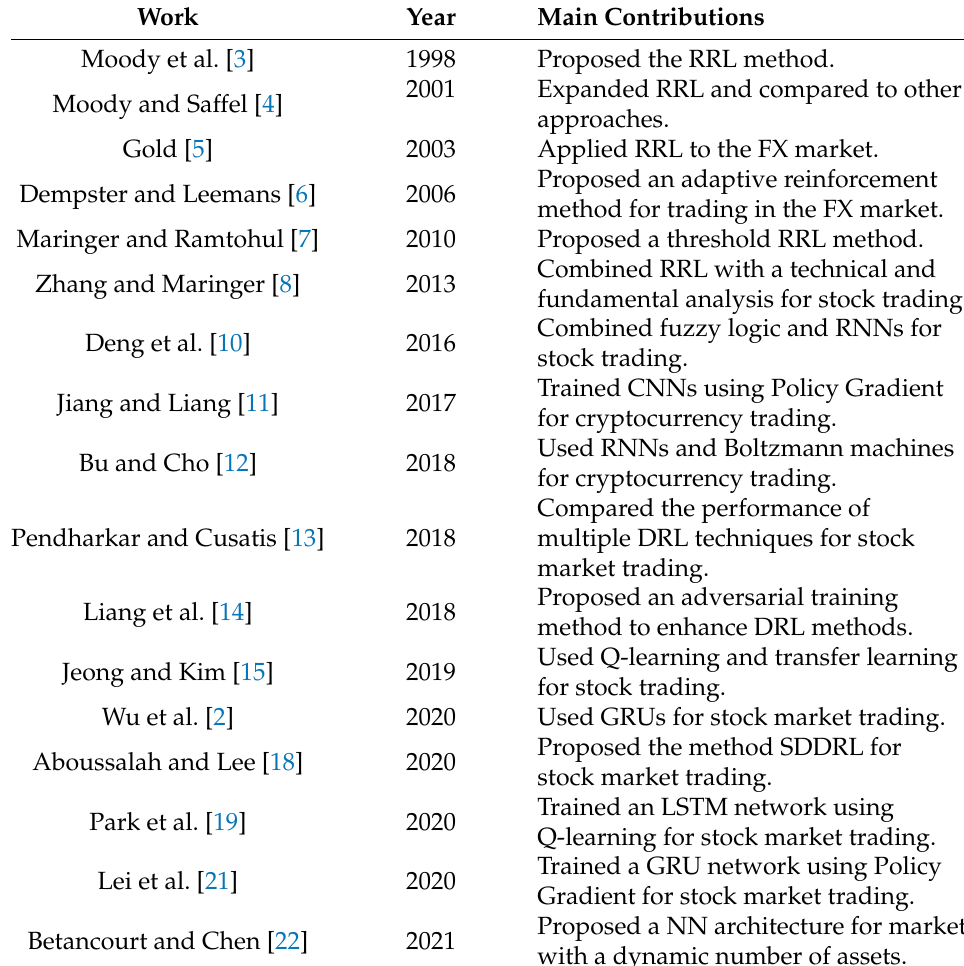
Table 1. Literature review